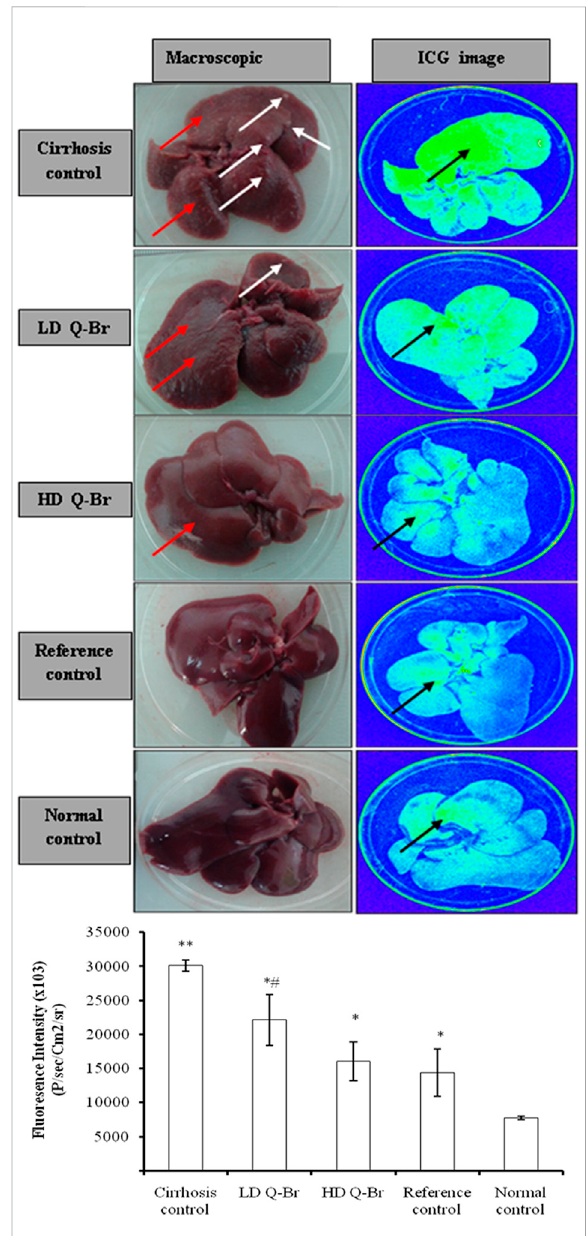
FIGURE 2 Impact of Q-Br treatment on the liver macroscopic and ICG fl uorescent images in sub-chronic liver injury induced by TAA for 15 weeks study. Left column represents macroscopic pictures of livers from different experimental groups and the right column represents the ICG fl uorescent images of the same livers of rats after intravenous injection of ICG (0.5 mg/kg). Cirrhosis control: TAA-treated rats; the LD Q-B-treated group (25 mg/kg); the HD Q-Br treated group (50 mg/kg); Silymarin-treated rats (50 mg/kg); Normal (apparently healthy): the liver from normal rat given 5% Tween 20. The white arrow represents macronodules of the cirrhotic liver, the red arrow represents micronodules, and the black arrow represents ICG-staining. The graph displays the ICG fl uorescent intensity measured from the rats ’ livers after intravenous injection of ICG bolus (0.5 mg/kg). The recorded measures are presented as Mean ± SD, while n = 3 and p ≤ 0.05 is signi fi cantly considered. ** p < 0.05 vs. normal group; * p < 0.05 vs. cirrhosis control group; and # p < 0.05 vs. Silymarin-treated